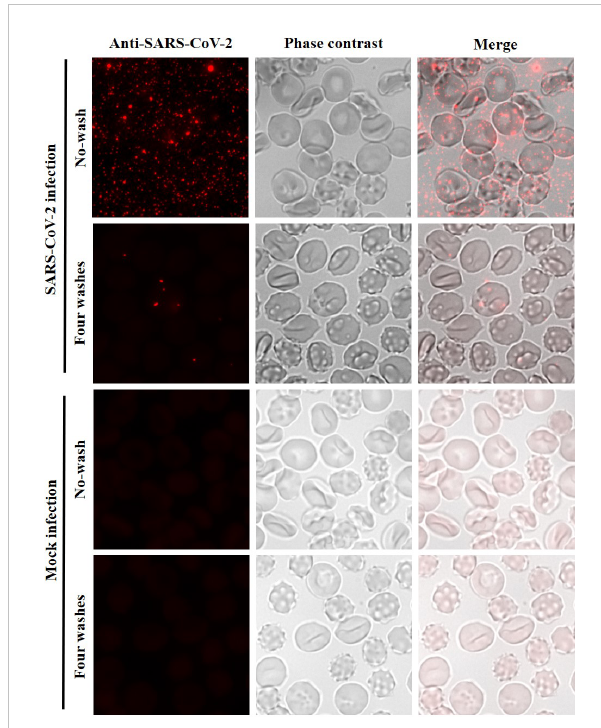
FIGURE 3 Low entry of SARS-CoV-2 to human erythrocytes. Immuno fl uorescence analysis using an anti-SARS-CoV-2 nucleocapsid antibody for detection of SARS-CoV-2 in infection assays with human erythrocytes. Erythrocytes were incubated with SARS-CoV-2 at MOI of 2 or with infection medium without virus (mock infection). No washed and four washed samples were analysed. Erythrocytes were visualized by phase contrast (gray). Maximum intensity projections of three-dimensional stacks are shown for the red channel. The percentage of erythrocytes with viral particles (red dots) attached after four washes was calculated counting several fi elds with a total of 2,490 red blood cells (10.94%; SD